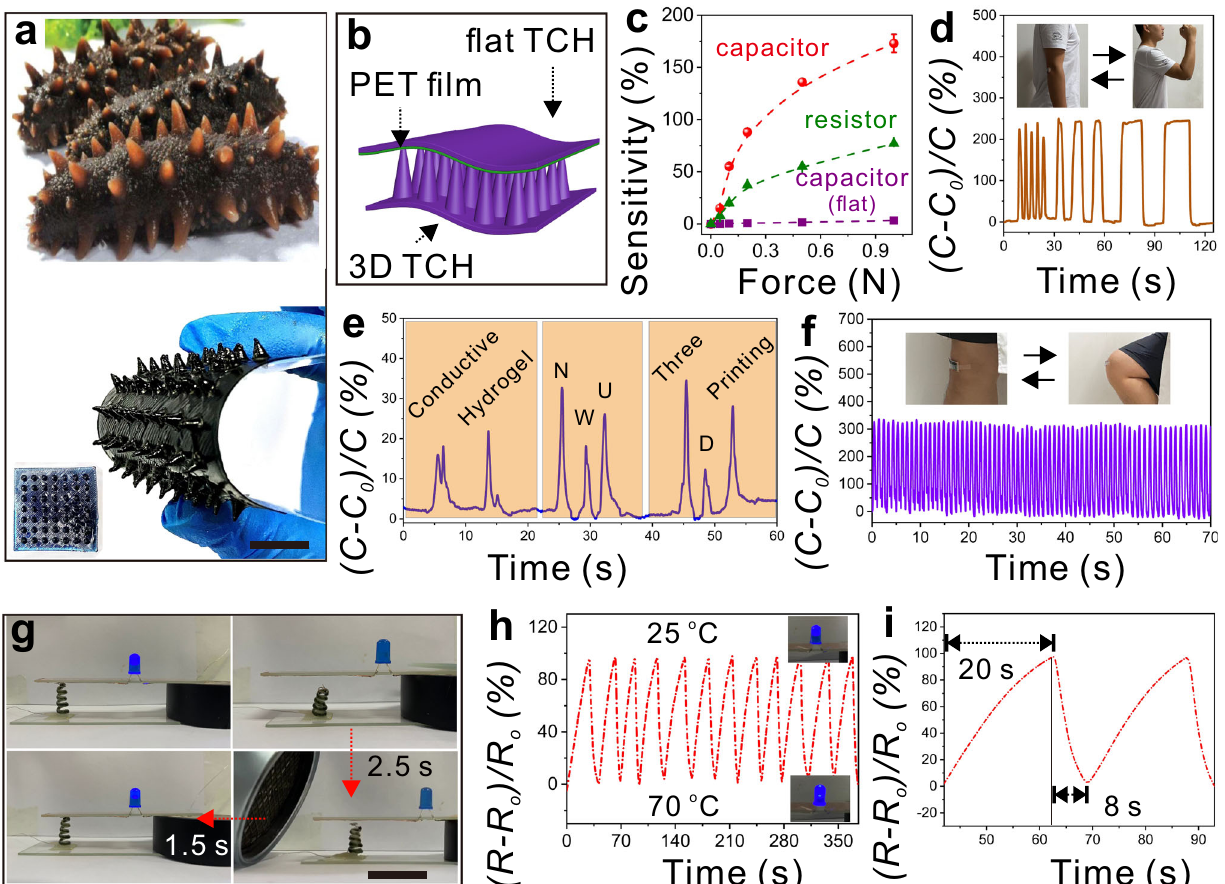
Fig. 5 Assembling TCHs to fl exible devices. a Bio-inspired designing a resistance sensor by 3D-printing TCH array and b assembling them to a 3D TCH capacitor. c The sensitivity of fl at and as-prepared 3D TCH capacitors, and resistance sensors with different external forces. Three samples were tested for each case. The 3D TCH capacitor sensor detects more slight human motions of d fl exing wrists with different speeds, e speaking, and f repeatedly fl exing wrists and knees. g A temperature-responsive smart device by using the shape-memory TCH as a conductor wine. h The real-time variation of current and light density with alternatively heating/cooling of the TCH conductor in ( g ). i The time vs. resistance change in the as-prepared TCH conductor. Scale bars in ( a ) and ( g ) are 1